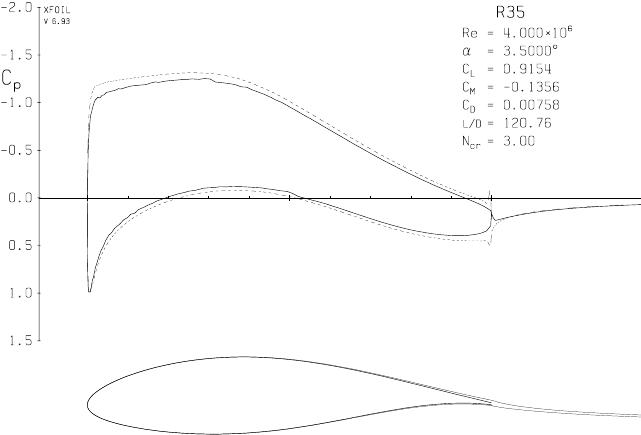
Figure8. StaticpressureonprofilefromFigure7usingXfoil. AOA3.5 ◦ . Figure 2. Static pressure on profile from Figure 1 using Xfoil. Angle of attack (AOA) is 3.5 ◦